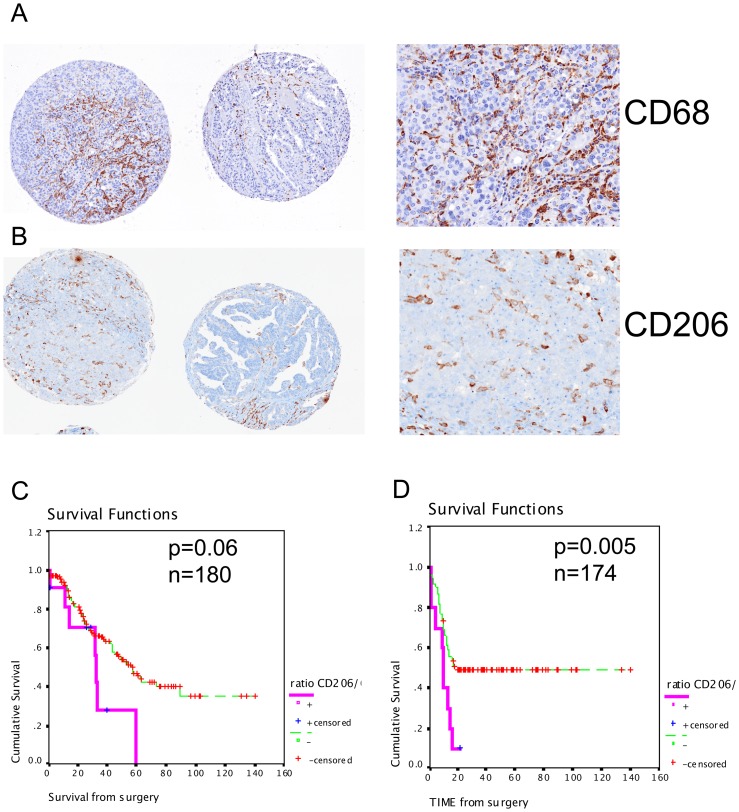
Representative staining for immunohistochemistry of infiltrating macrophages.High and low density of CD68+ (tumor-associated macrophages, TAM) (A) and CD206+ (M2 subtype of TAM) cells (B). Magnification in the high infiltration area is shown on the right panel for each staining (top). C and D. Kaplan-Meier analysis of the ratio of infiltrating intraepithelial CD206+/CD68+ cells representing the relative density of CD206+ M2 TAM over the total density of CD68+ intraepithelial infiltrating macrophages. Kaplan-Meier curves of overall survival (C) and disease-free survival (D) in 180 and 174 patients, respectively. Significance (p) is indicated by log rank.